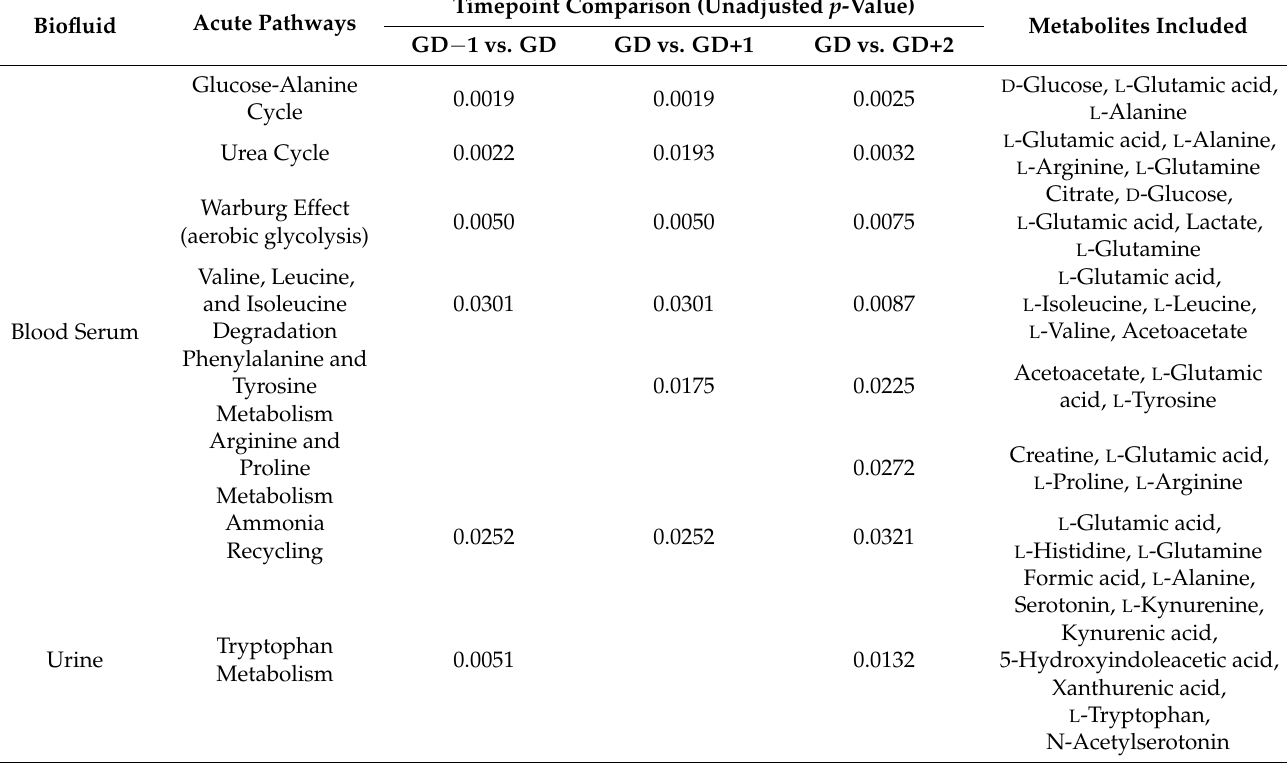
Table 1. Metabolites identified as key discriminators between samples collected immediately post-match play (GD) and the GD − 1, GD+1, and GD+2 timepoints via PLSDA modelling were then put forward for pathway enrichment analysis using MetaboAnalyst 4.0. The unadjusted ranked p -values are displayed here.